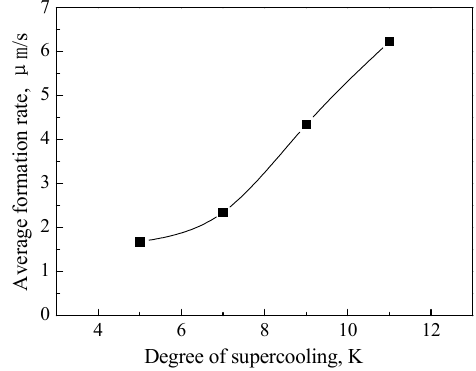
Figure 8. The growth rate of CP hydrate crystals at different supercooling degrees.